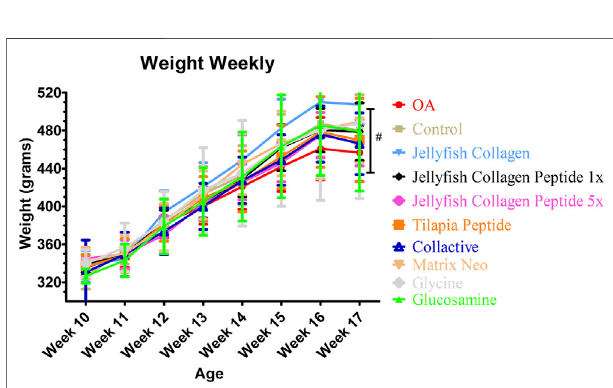
FIGURE 2 | Average weekly weight of